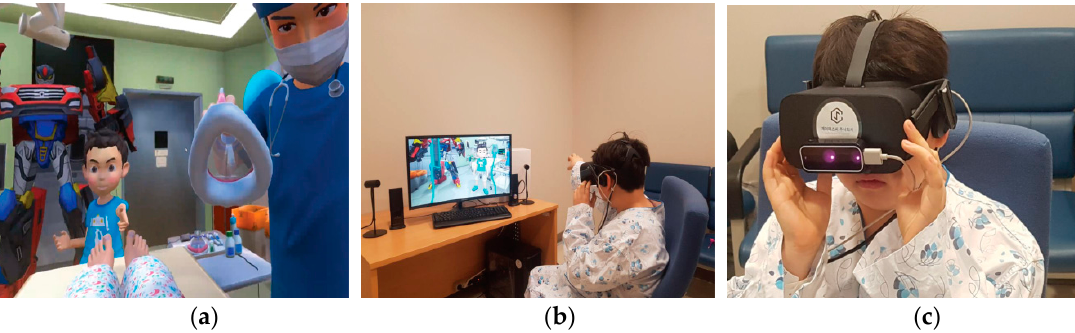
Figure 1. Virtual reality video game. ( a ) Players experience general anesthesia induction in a 360 degree, three-dimensional virtual environment, through first-person viewpoint; ( b ) can interact with virtual devices; ( c ) with a head-mounted VR display and a hand and finger motion controller.